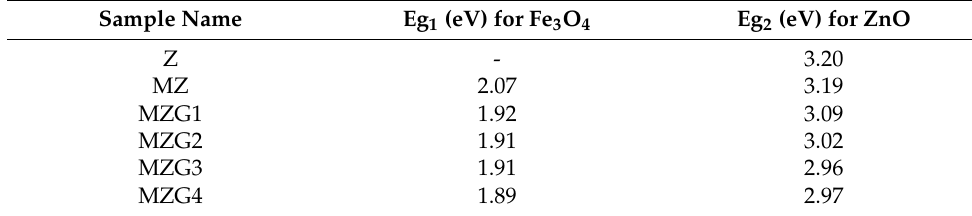
Figure 5. ( a ) Diffuse reflectance spectra and ( b ) photoluminescence spectra of Z, MZ, MZG1, MZG2, MZG3, and MZG4 crystalline nanocomposites. Table 1. The band gap energy (Eg) values of all